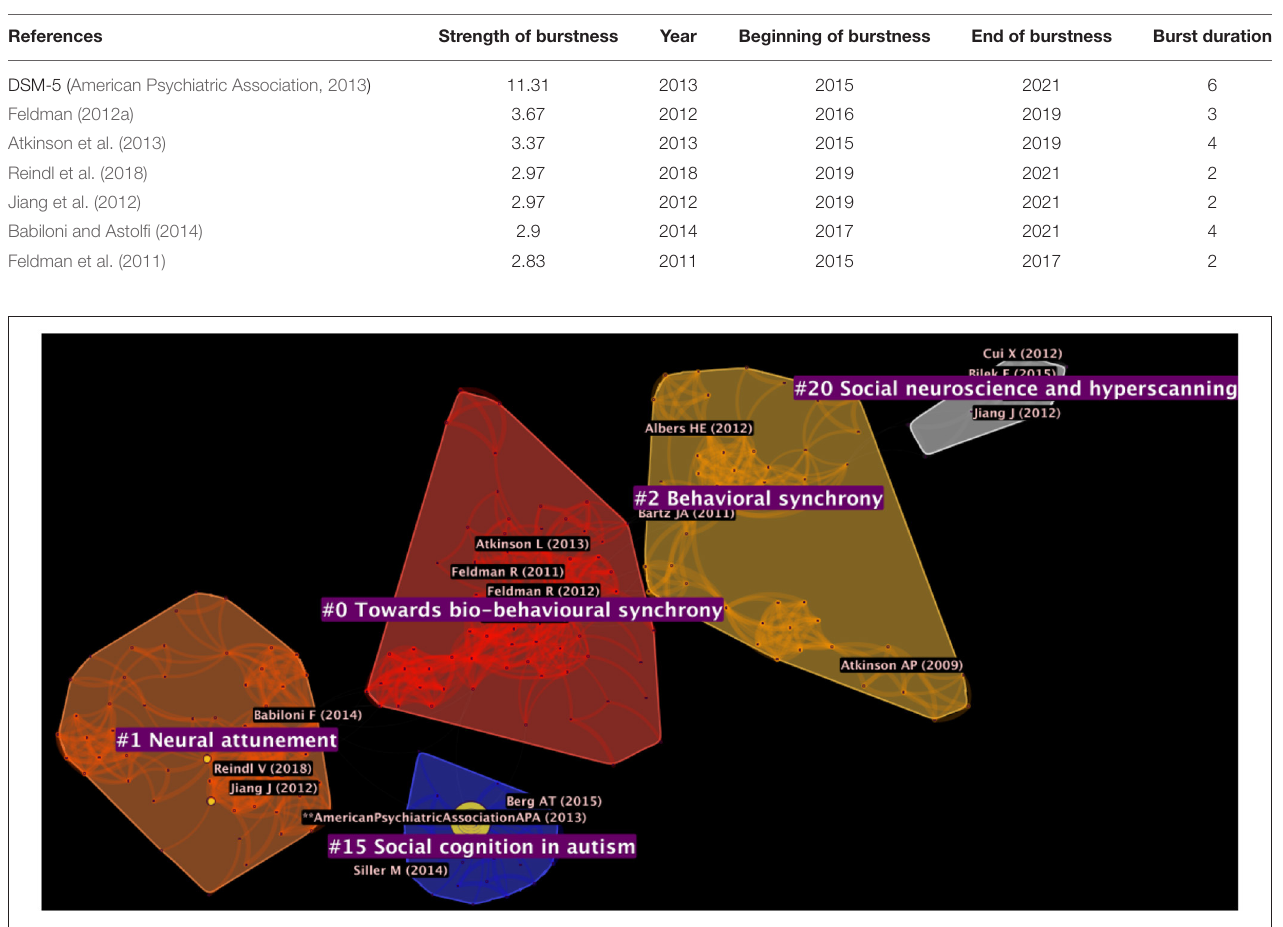
TABLE 1 | Identifying characteristics of the 7 publications with high citation burstness metrics generated in the DCA.